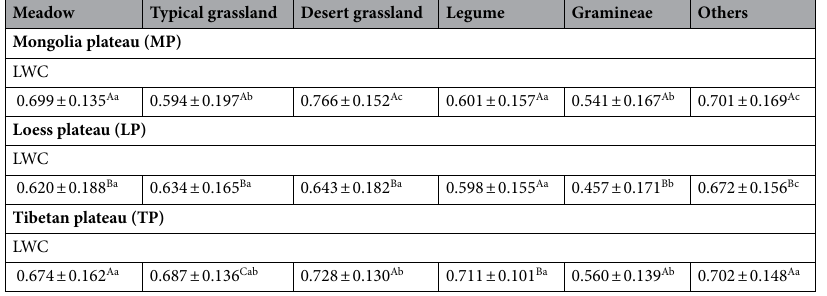
Table 1. Changes to leaf water content (LWC, g g −1 ) among different plant life forms and different grassland types. † Significant differences were tested at P = 0.05, and different lowercase letters indicate significant differences. Lowercase letters compare different grassland types on the same plateau, while capital letters compare grassland types on different